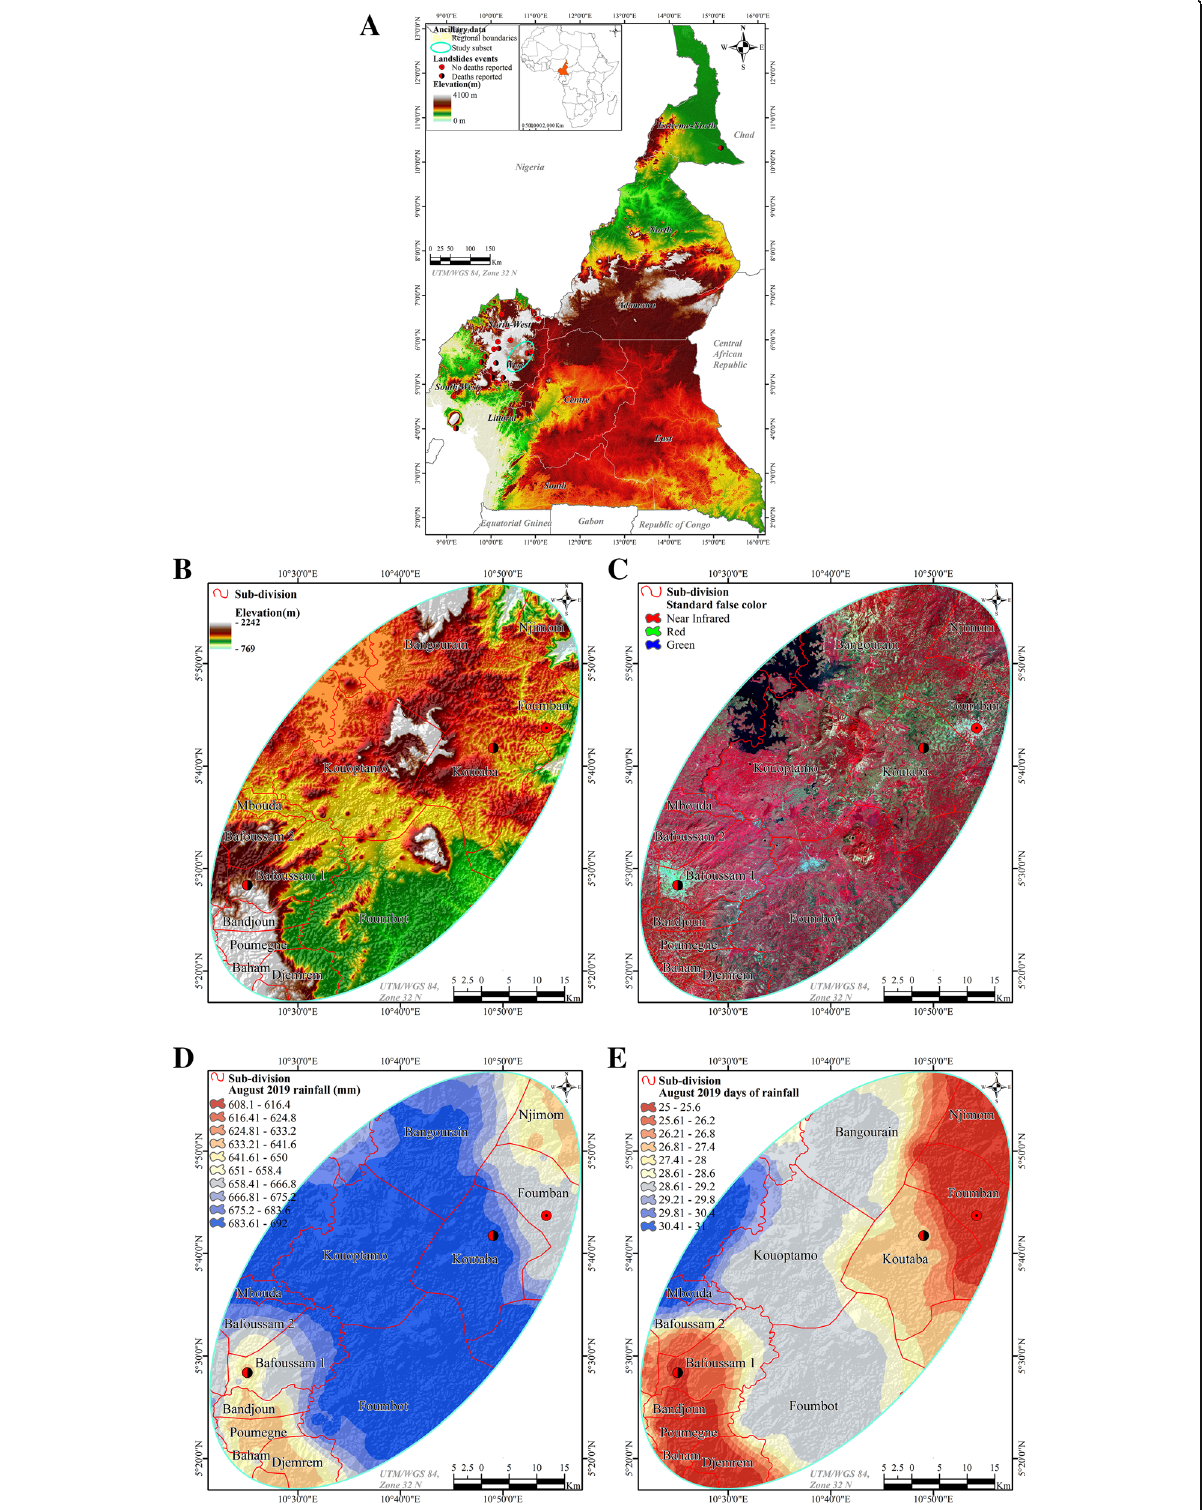
Fig. 1 The study location: A Landslides events on the elevation background in Cameroon, B & C Subsets of elevation and Landsat 8 satellite image. D Interpolation of average rainfall for August 2019, E Interpolation of days of rainfall for August